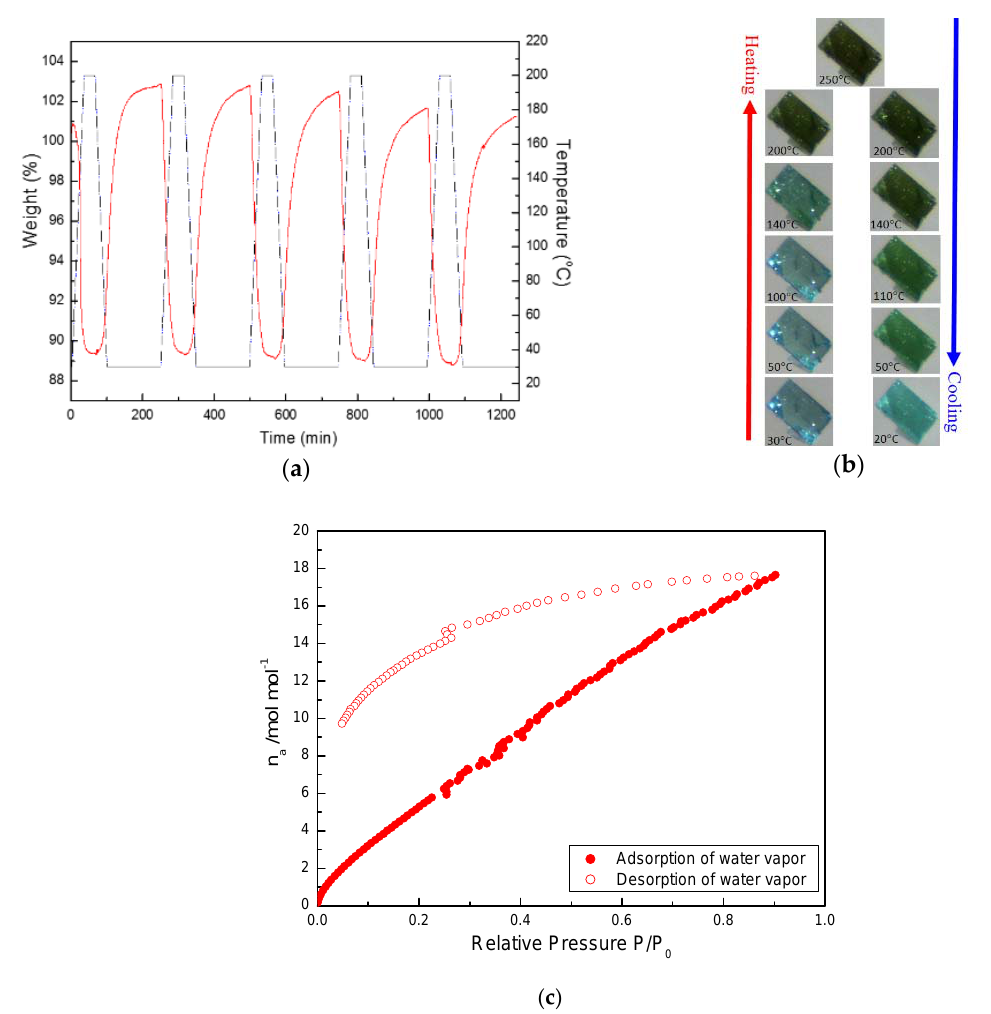
Figure 4. ( a ) TG measurements of cyclic de-/re-hydration processes for 1 were repeated four times. Solid red line: the variation of weight loss with time; black dash-dot line: the variation of temperature with time. ( b ) Photographs of plate-shaped crystal 1 at different temperatures. ( c ) Water Vapor ad-/de-sorption isotherms at 298 K for 1 .